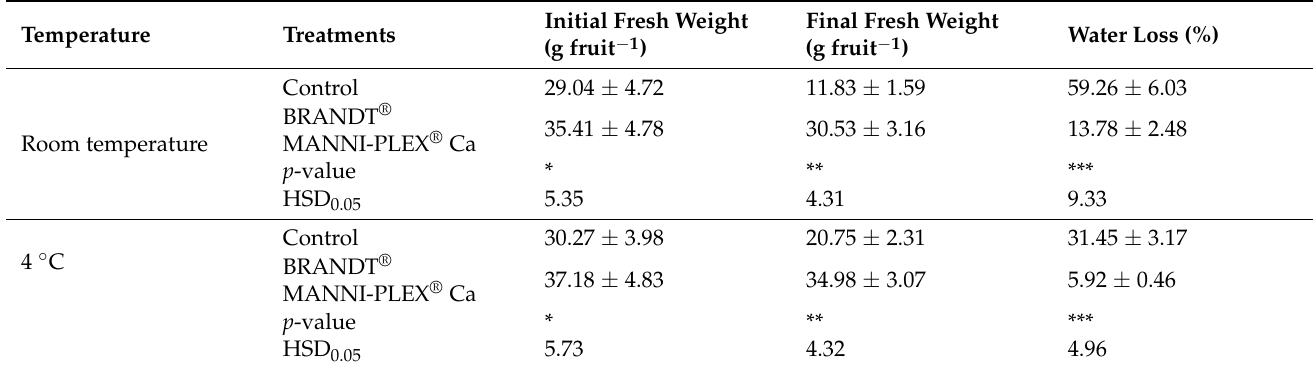
Table 4. Effect of BRANDT ® MANNI-PLEX ® Ca application on the initial and final fresh weight and water loss percentage in pepper fruits subjected to post-harvest at room temperature and 4 ◦ C.